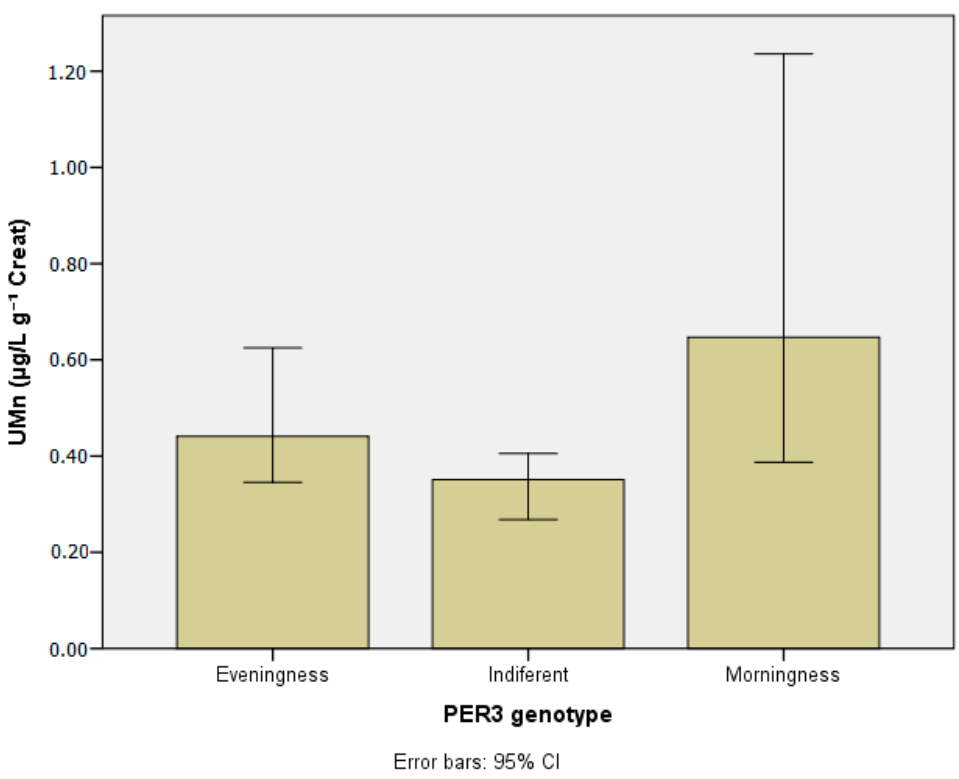
Figure 5. Manganese in urine ( μ g g − 1 creat) according to PER3 gene VNTR polymorphisms.